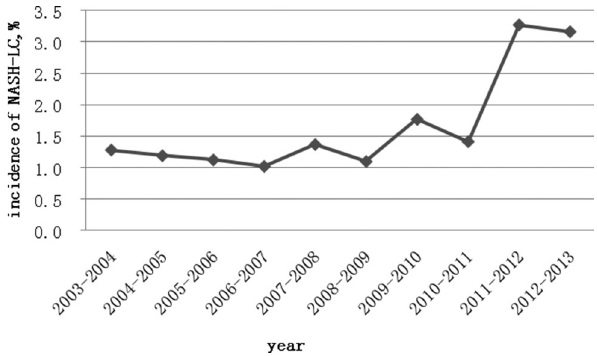
Figure 2 - Time trend of NASH-related LC over the ten year period from 2003-2013.